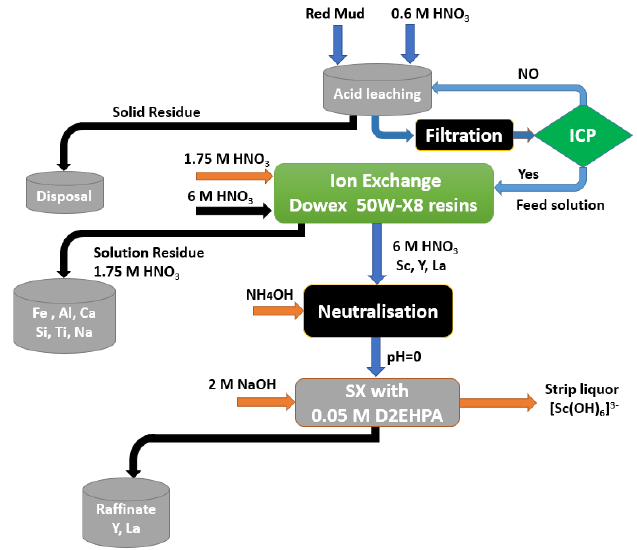
Figure 15. Proposed flow-chart for scandium recovery from RM, adapted from [140].